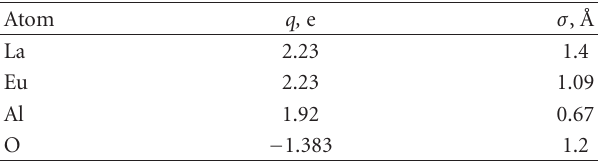
Table 1: Potential parameters.